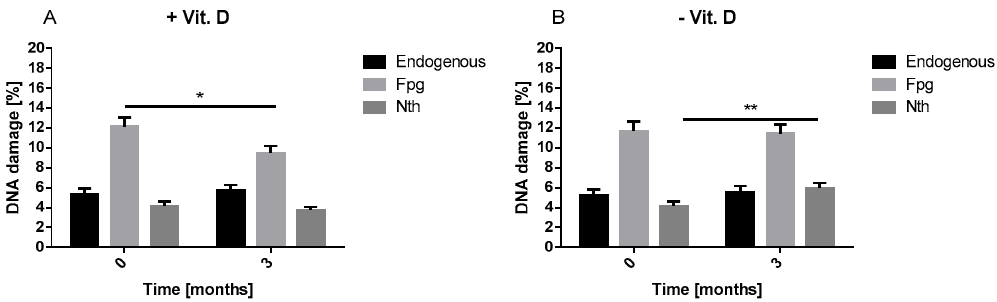
Figure 3. The impact of three-month supplementation of vitamin D on the level of endogenous and oxidative DNA damage in the intervention group ( + Vit. D, n = 48) in relation to the comparative group ( − Vit. D, n = 44). The level of DNA damage was measured by the alkaline comet assay. Data are expressed as mean ± SEM. * p < 0.05; ** p < 0.01.